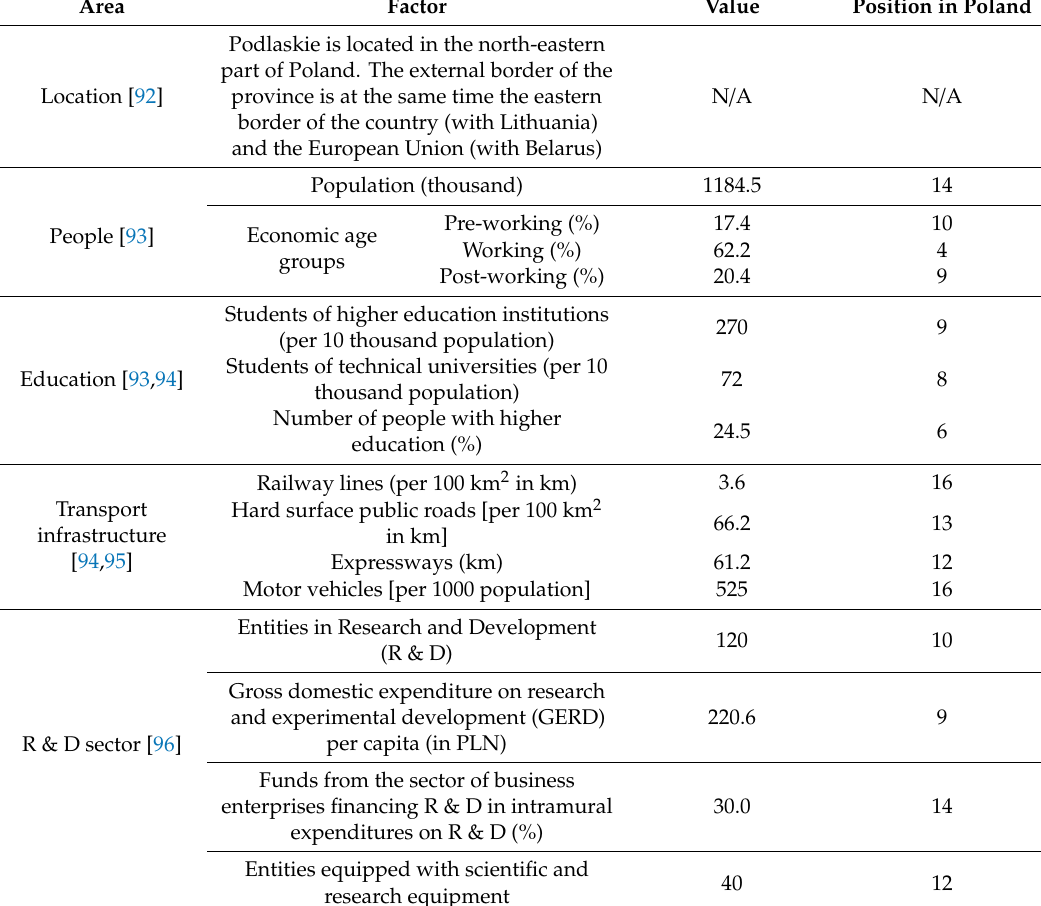
Table 3. Selected characteristics of Podlaskie Voivodeship in the areas of Industry 4.0 regional environment. Area Factor Value Position in